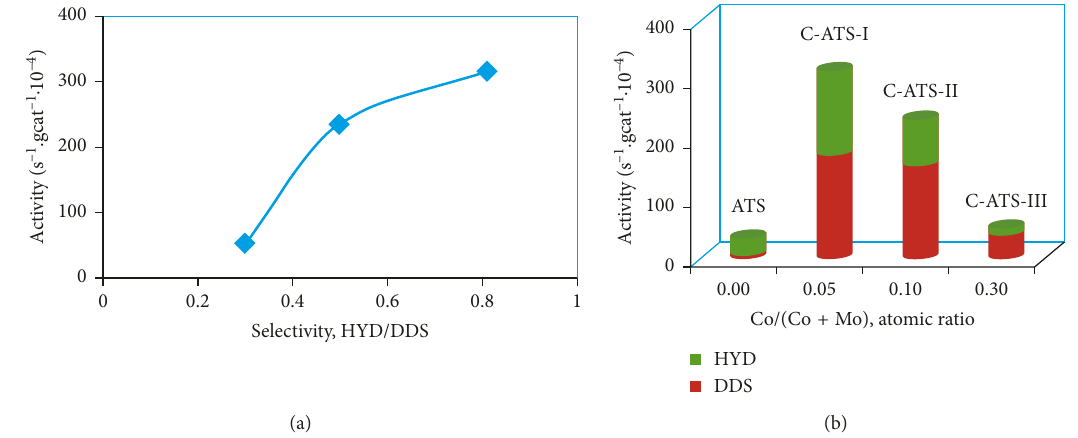
Table 2: Changes in the selectivity of the HDS reaction for the MoS 2 -based catalysts caused by Co and H 2 S. Comparison of the average fold change (increase or decreases) in the activity of the ATS catalyst due to the inclusion of Co Reaction condition Absence of H 2 S Presence of H 2 S Catalyst C-ATS-I C-ATS-I DBT Comparison of the average fold change (increase or decrease) in the activity caused by H 2 S Catalyst C-AHSG-II HYD